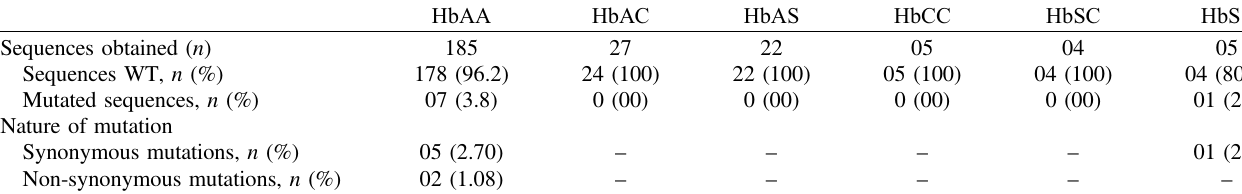
Table 5. Prevalence of K13 -propeller gene mutations according to hemoglobin type. HbAA HbAC